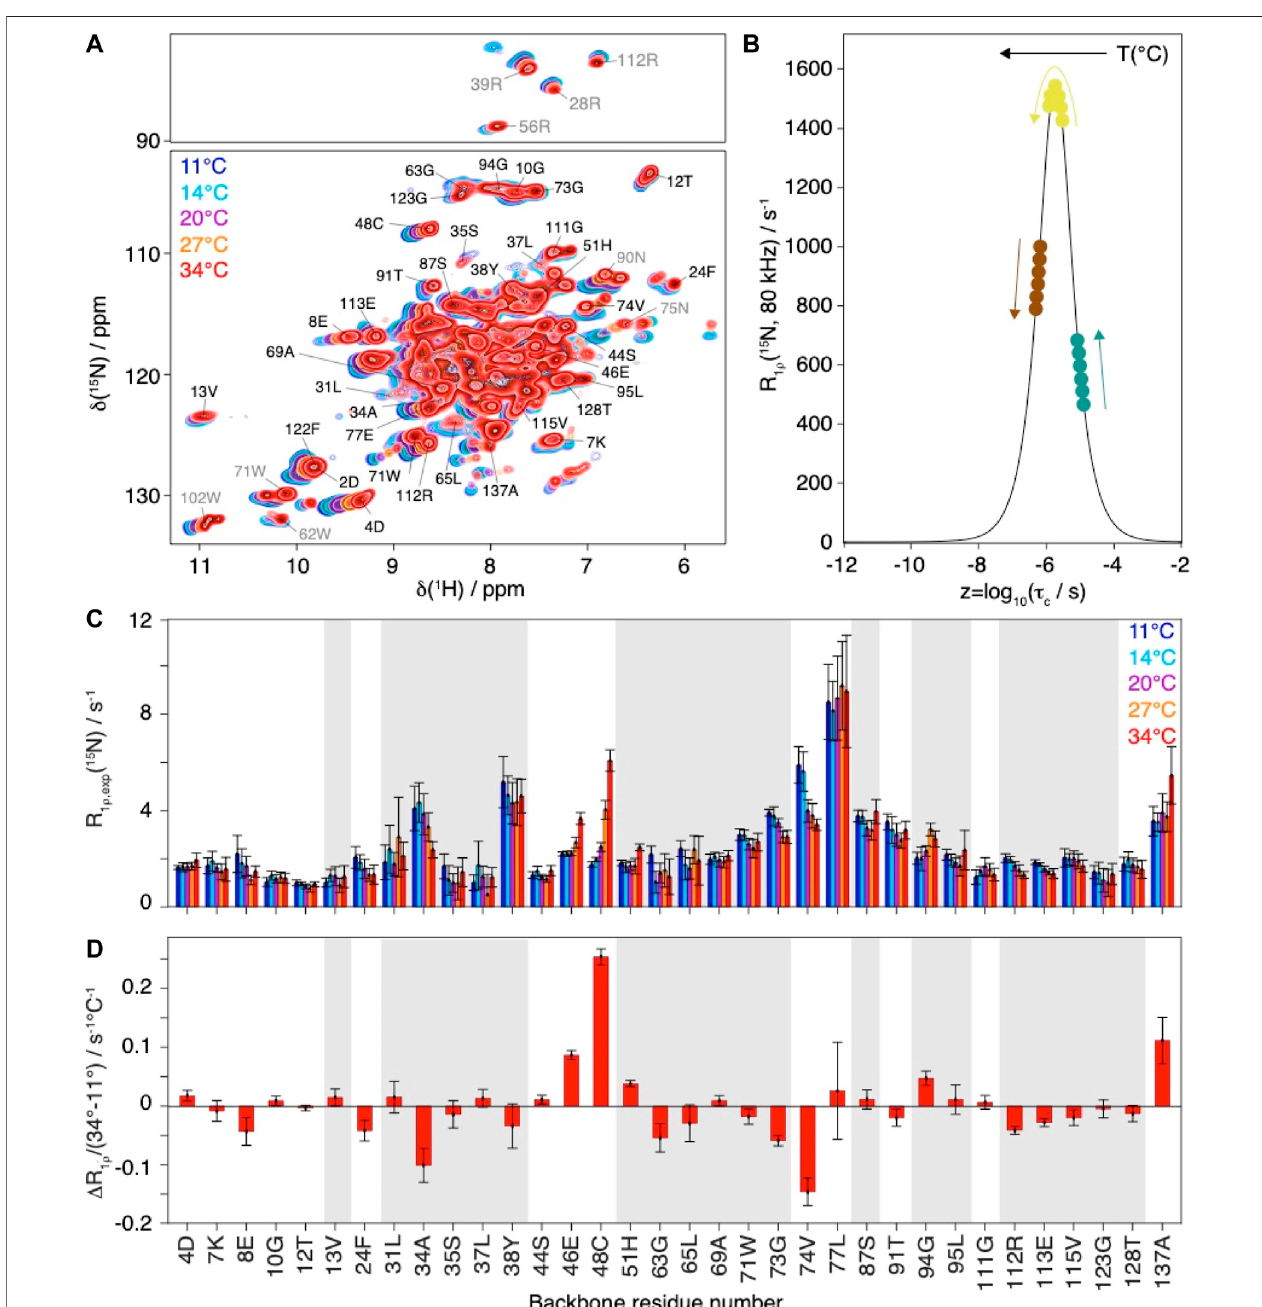
FIGURE 3 | Evolution of Cp149 relaxation-rate constants as function of the temperature. (A) Overlay of 2D hNH spectra of Cp149 capsids recorded at 80 kHz MAS,28scansand15.8 msacquisitioninthe 15 Ndimensionat11 ° C(blue),14 ° C(cyan),20 ° C(purple),27 ° C(orange)and34 ° C(red). Theassignmentistransferredfrom Lecoq et al. (Lecoq et al., 2019). (B) Normalized analytical R 1 ρ ( 15 N, ] r (cid:1) 80 kHz, ] 1 (cid:1) 13 kHz) rate constant as function of the correlation time. The colored dots and arrows indicate the evolution oftherate constantwith temperature depending on its originalpositionon thecurve. (C) Selectedexperimental site-speci fi cvaluesof R 1 ρ ( 15 N, ] r (cid:1) 80 kHz, ] 1 (cid:1) 13 kHz) measured between 11 ° C (blue) and 34 ° C (red) for the backbone residues and ( D) Site-speci fi c gradients for the change in relaxation rate constant between 34 ° C and 11 ° C, Δ R 1 ρ / Δ T (cid:1) (R 1 ρ (34 ° C) - R 1 ρ (11 ° C))/(34 ° C-11 ° C). The error bars have been calculated with Gaussian error propagation. In both graphsthe bars forresidues 2D and 122F have been marked byan (*), due tothe relaxation databeing biased bythe overlap ofthe tworesonances inthe hNH at higher temperatures. Grey shaded areas indicate α - helical secondary structure.